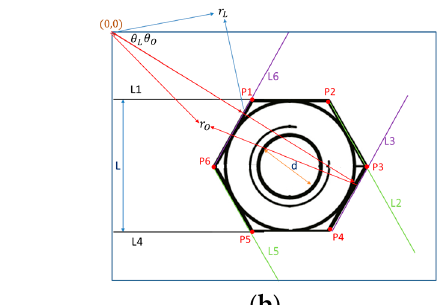
Figure 4. Using gradient direction to fi nd out the six directions.